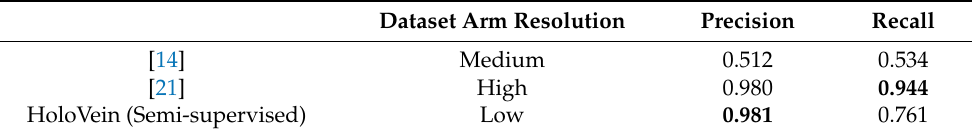
Table 3. Performance comparison across existing U ‐ Net solutions, with highest score per evalua ‐ tion metric in bold.